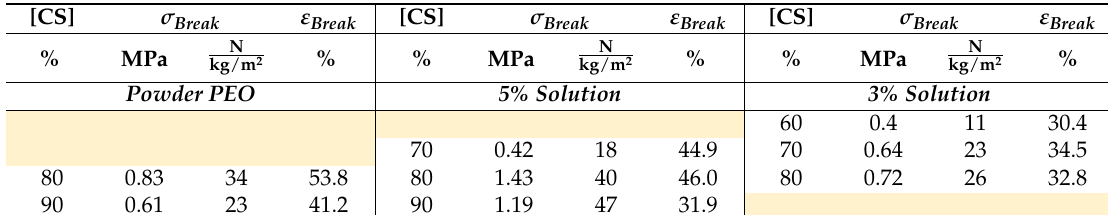
The uniaxial stress/strain properties on nanofibers mat under hydrated form after neutralization and PEO extraction, drying and rehydration. ( MW = 5 × 10 6